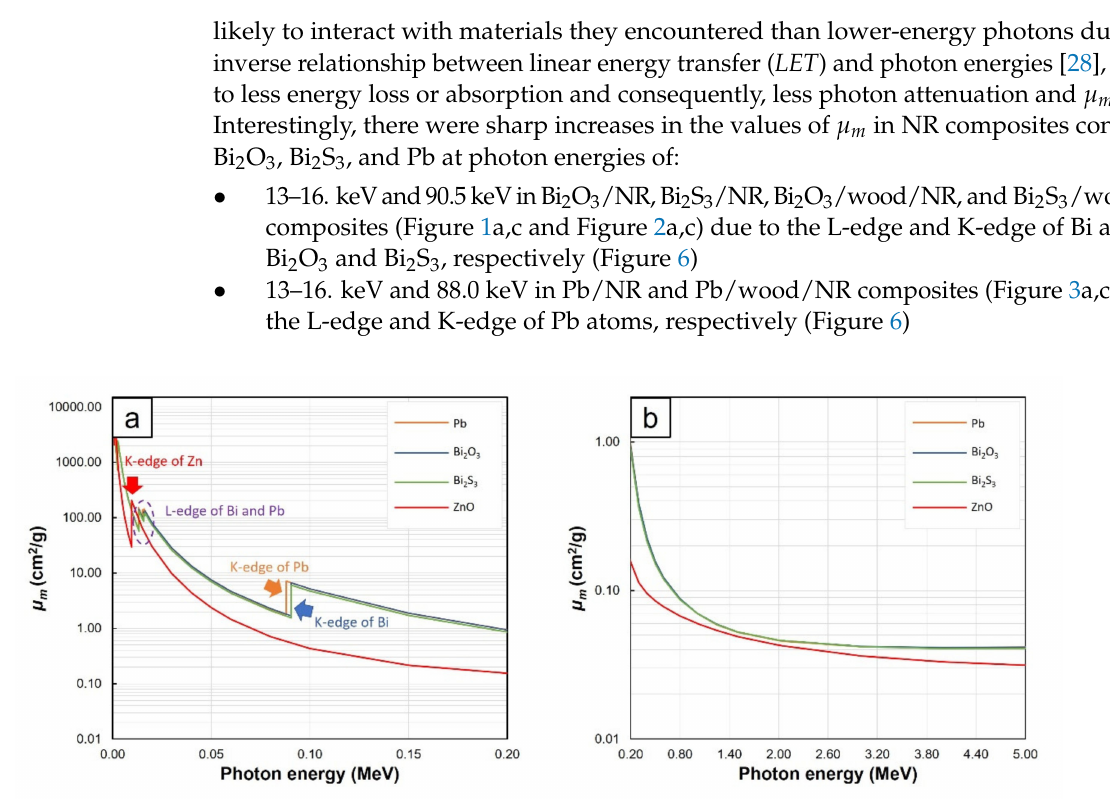
Figure 6. µ m values of Pb, Bi 2 O 3 , Bi 2 S 3 , and ZnO, showing K-edge and L-edge behavior of Pb, Bi, and Zn at photon energies of ( a ) 0.001–0.2 MeV and ( b ) 0.2–5